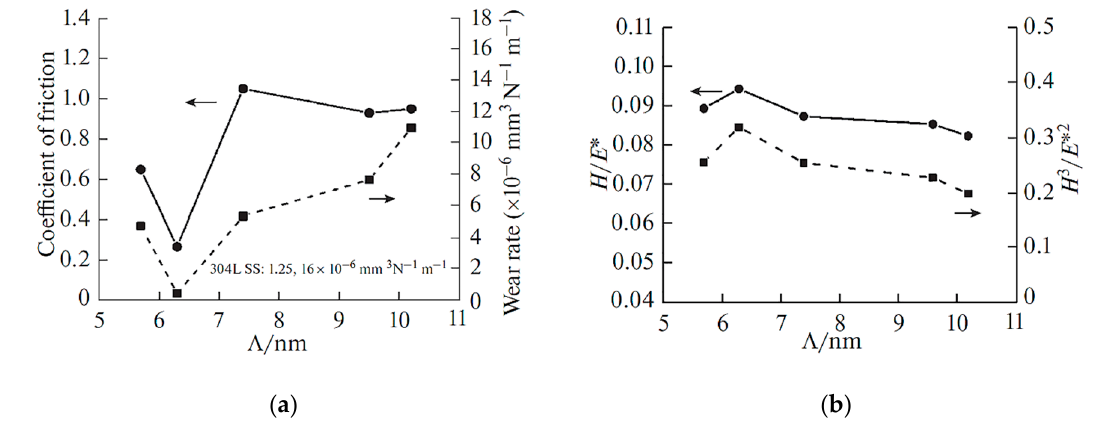
Figure 17. Friction coefficient and specific wear rate ( a ), H/E* and H 3 /E* 2 ratios ( b ) as a function of the bilayer thickness of CrN/TiN multilayer superlattice coatings. Reprinted with permission from [142] 2018 Springer Nature.